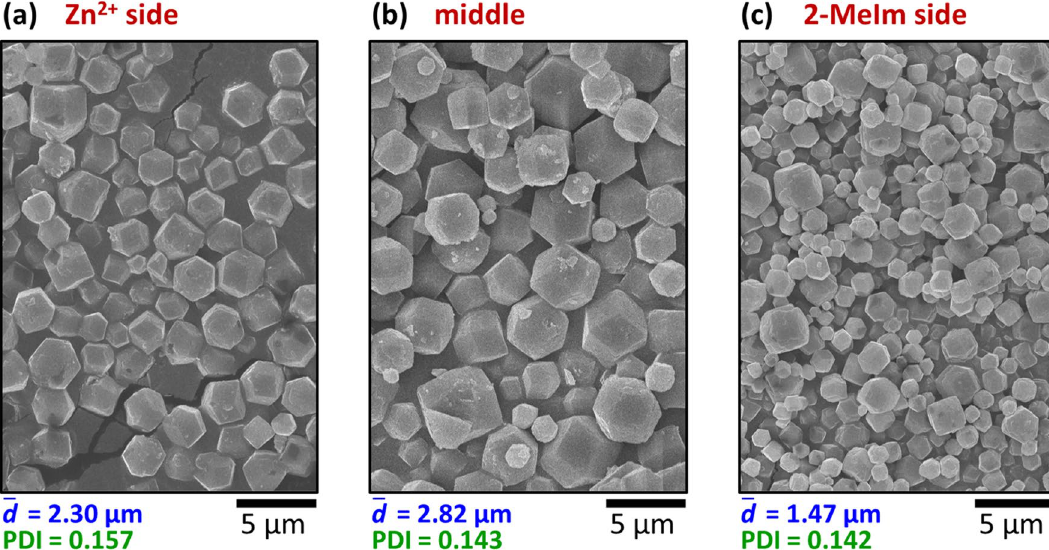
Figure 5. Particle size at different spatial positions along the direction of the cross-gradients (Zn 2+ side, middle zone, and 2-MeIm side) in the out-of-equilibrium synthesis represented in SEM micrographs ( a – c ). The boundary concentrations were fixed to [Zn 2+ ] 0 = 25 mM and [2-MeIm] 0 = 250 mM, and the synthesis time was 24 h. The average particle size (cid:31) d (cid:30) and the polydispersity index (PDI) are given below the SEM